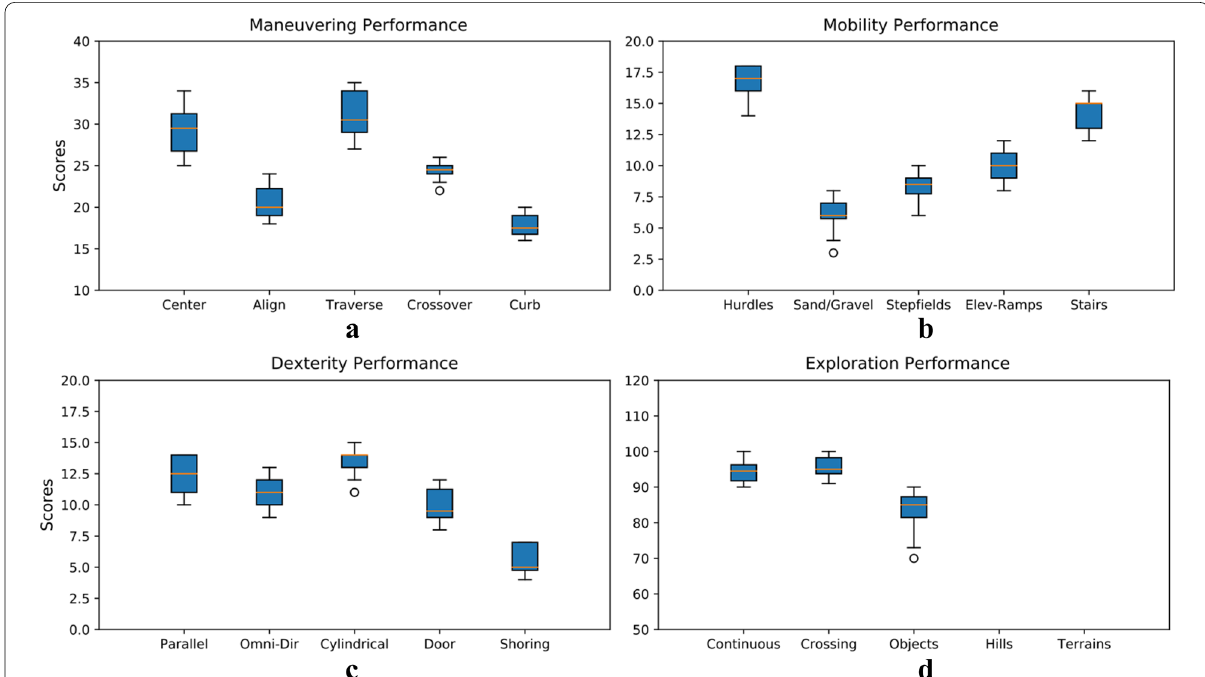
Fig. 24 The results of Karo’s performance in RRL’s test